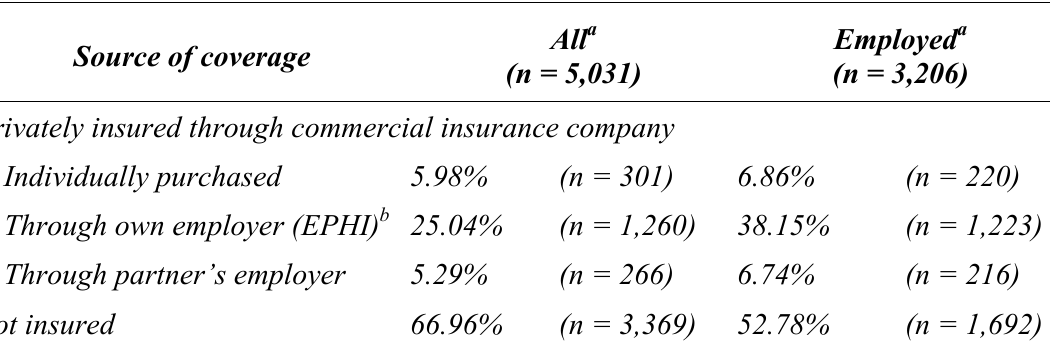
Source of private health insurance coverage for the total sample of the Danish population aged 18-75 and the subsample of employed, 2009 Source of